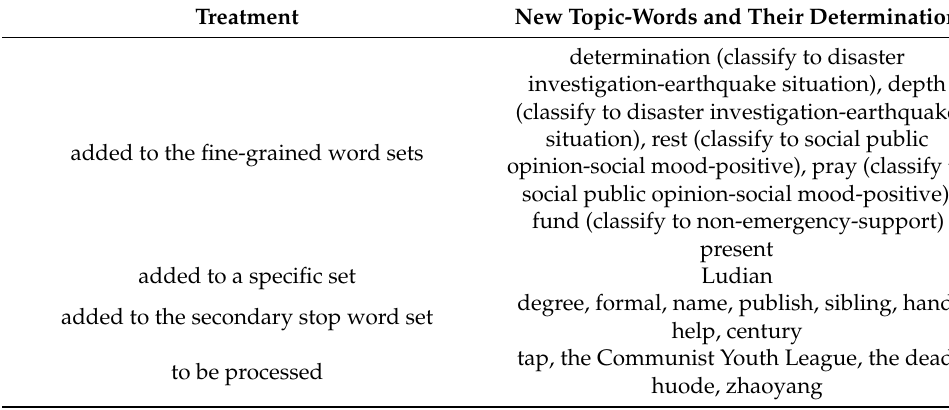
Table 11. Decision of new topic-words in the Ludian